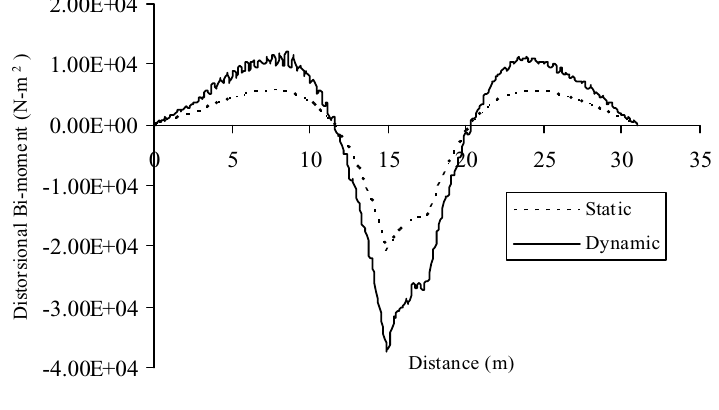
Fig. 16. Time histories for distortional bimoment.